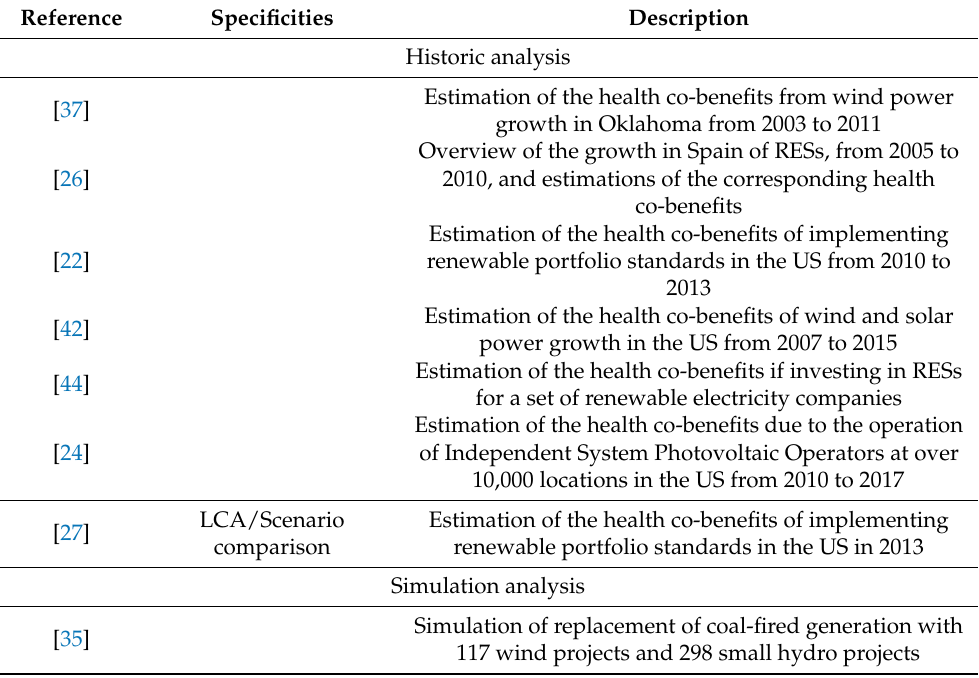
Table 4. Studies included in the SLR and their methodology (source: own